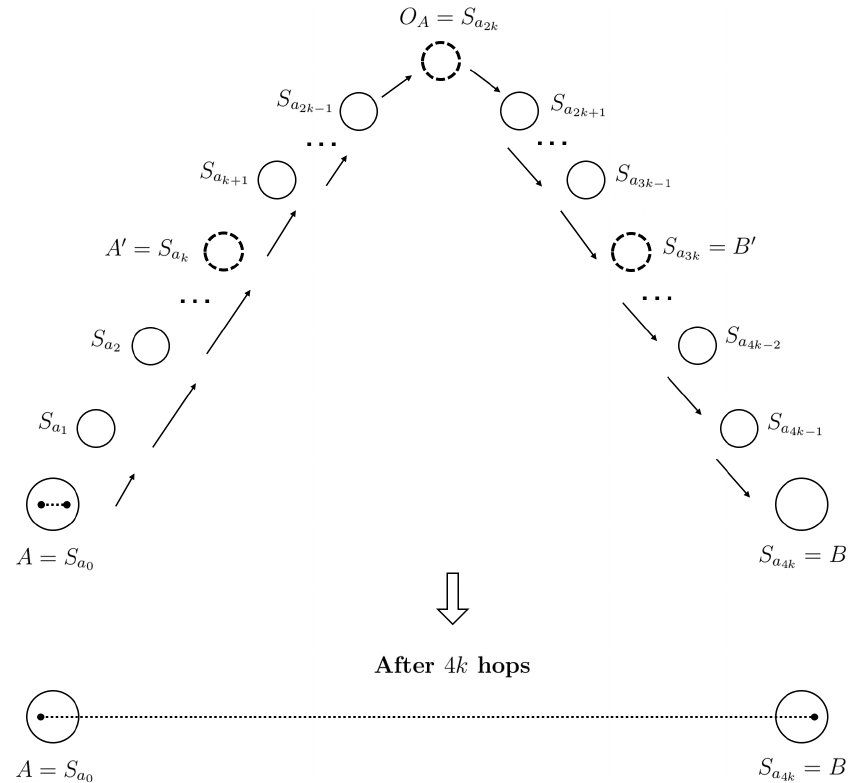
Figure 2. Tree-like illustration of a configuration of N = 4 k − 1 active quantum switches on route from A to B (tilde notation dropped to avoid cluttering). Dotted black lines connect entangled particles, as it is initially seen at Alice. A sequential distribution of entanglement from Alice to Bob implies that one particle of Alice’s entangled pair goes through 4 k nodes to eventually reach Bob. This process would take t 0 = 4 k units of time.